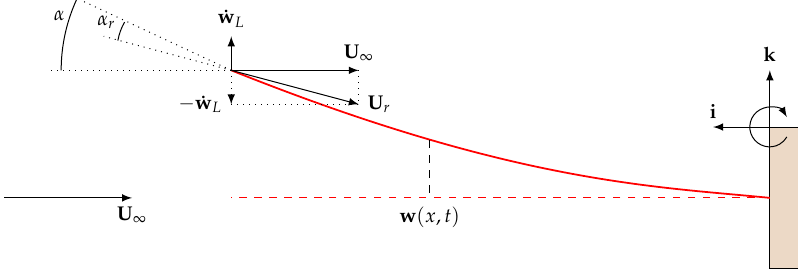
Figure 3. Sketch of the quantities appearing in the model